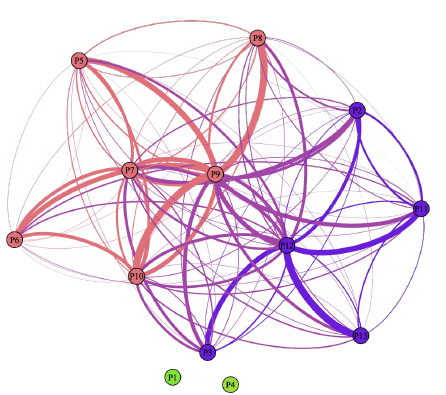
Figure 9. Participant sub-communitiesin the